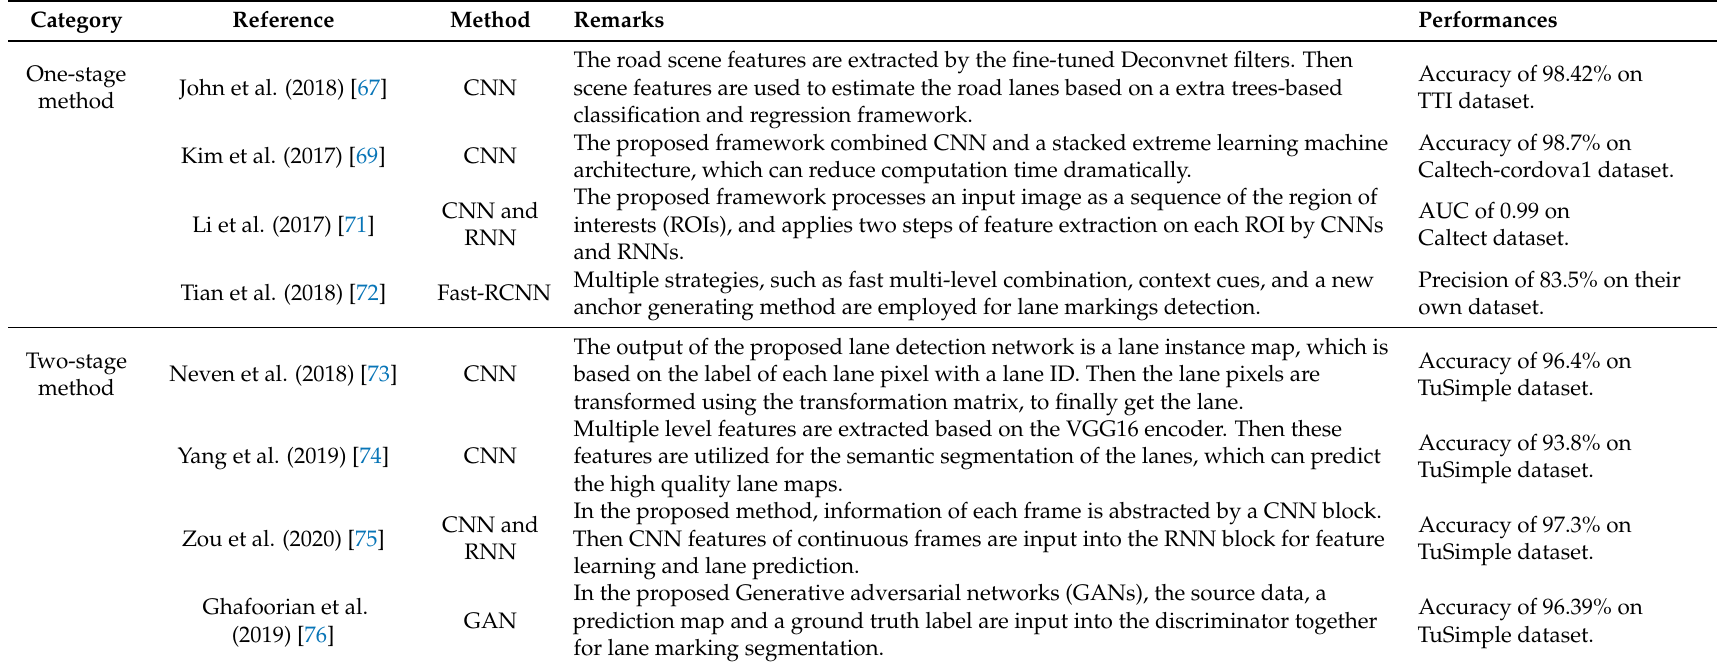
Table 4. A summary of the lane detection methods based on deep